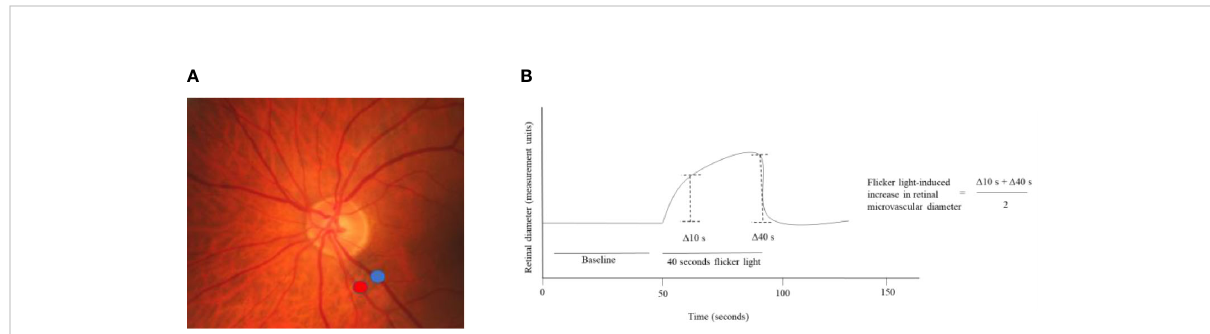
FIGURE 2.4 Flicker light-induced increase in retinal microvascular diameters. (A) Shows where the increase in retinal arteriolar (red) and venular (blue) diameters in response to fl icker light exposure can be assessed around the optic nerve head. (B) Shows that the baseline diameter is assessed during the fi rst 50 seconds of the measurement and that during 40 seconds of fl icker light the retinal diameter increases. The fl icker light- induced increase in retinal diameters is calculated from the retinal diameter at 10 and 40